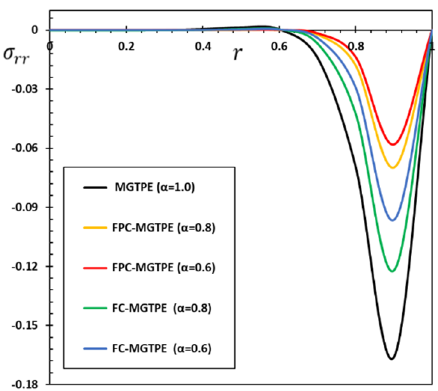
Figure 4. The hoop stress variation 𝜎 (cid:3107)(cid:3107) for different fractional derivatives. Figure 5. The carrier density 𝑁 for different fractional derivatives.